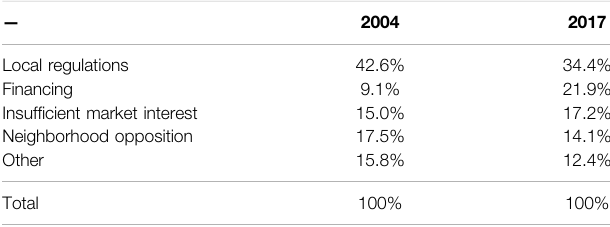
TABLE 13 | Changes of percent of most signi fi cant challenges encountered from 2004 to 2017.